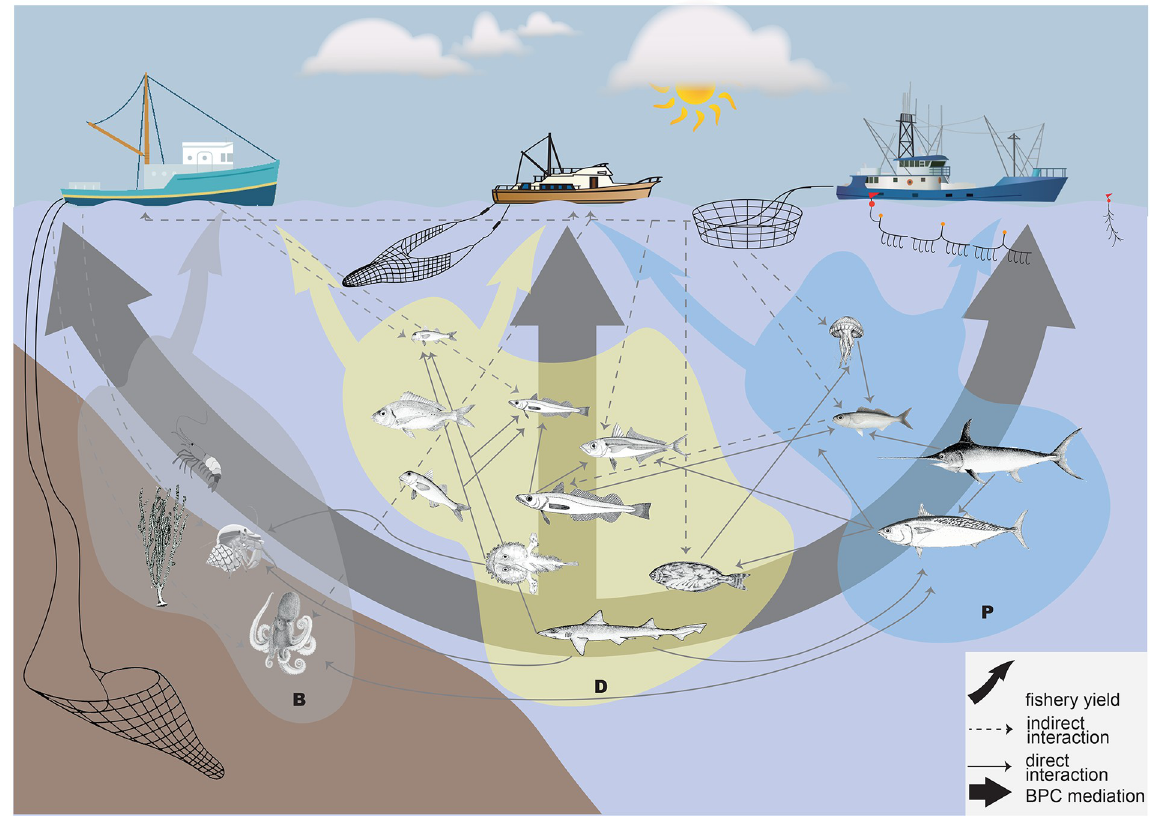
Fig 9. BPC mediates mixed fisheries: Main fleet and biological overall impacts (direct and indirect) through the three domains. Gray cloud = benthic domain, yellow cloud = demersal domain, blue cloud = pelagic domain. From left to right the fleets represent: bottom trawl, pair and mid-water trawl, purse seine and